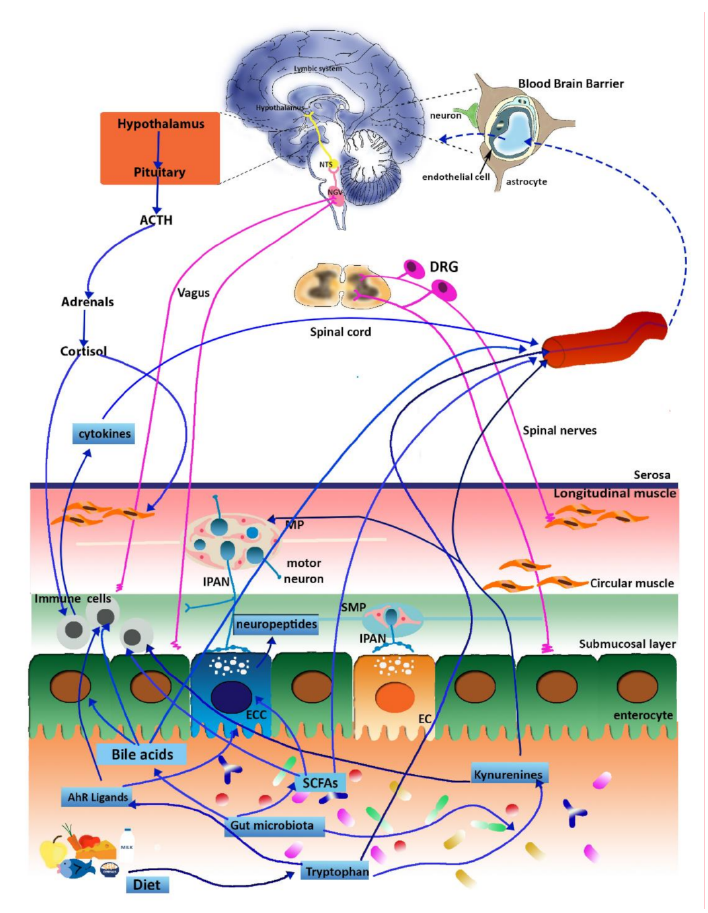
Figure 1. Schematic representation of the microbiota–gut–brain axis. Signals from the gut saprophytic microflora reach the central nervous system (CNS) and the enteric nervous system (ENS) via different pathways, including endocrine, immune, metabolic, and neuronal pathways as described in the text. In normal conditions, the blood–brain barrier allows the access of tryptophan, kynurenines, SCFAs, and bile acids. Abbreviations: NTS, the nucleus of the solitary tract; NVG, nodose vagal ganglion; DRG, dorsal root ganglion; MP, myenteric plexus; IPAN, intrinsic primary afferent neurons; SMP, submucosal plexus; ECC, enteroendocrine cell; EC, enterochromaffin cells; SCFAs, short-chain fatty acids (adapted from Baj et al., 2019